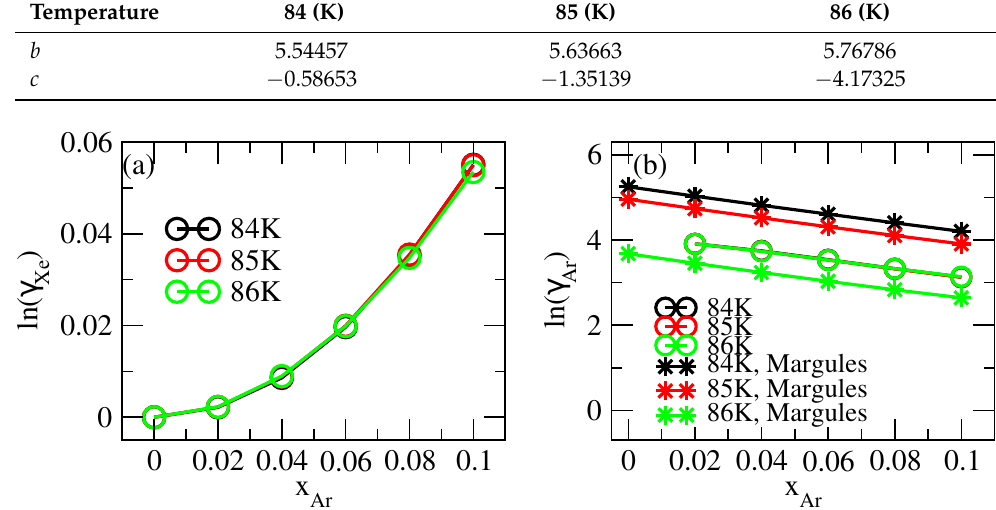
Figure 10. Evolution of ln γ with x Ar for ( a ) Xe and ( b ) Ar. Values obtained from simulation data via Γ (circles) or from a fit to the Margules equations (stars).